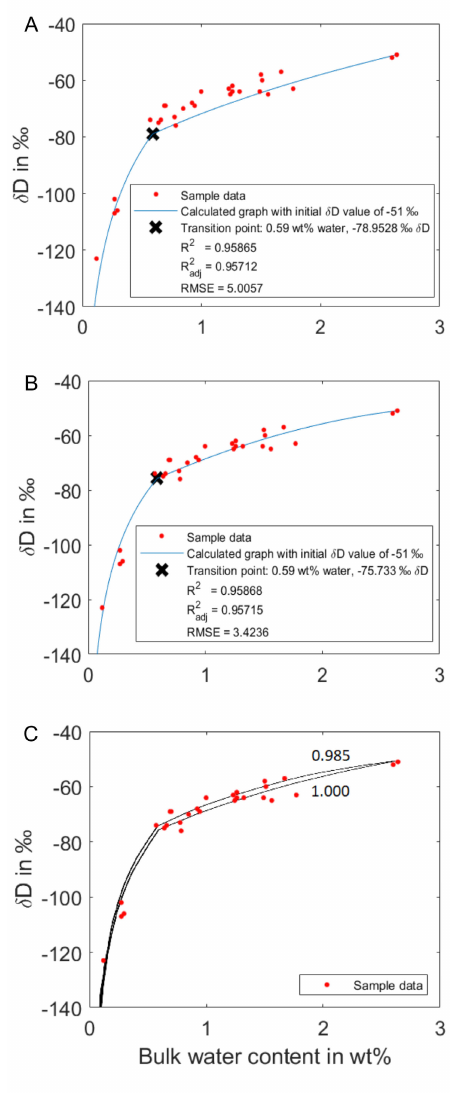
Figure 3: Diagrams illustrating δ D values versus bulk H O content (in wt.%) of the C.E. 1340 Mono Crater 2 eruption based on the sample data and initial values from [Dobson et al. 1989; Newman et al. 1988]. [A] and [B] show the computed values by VolcDeGas . The blue line displays the VolcDeGas simulated closed-, to open- system degassing graph, the red dots the sam- ple data and the black cross shows the transition where the degassing system changes. [C] presents a published Figure 2: Comparison of estimates of alpha factor plot- model fits to data from the literature [Dobson et al. ted against bulk H O content (in wt.%) for the C.E. 2 1989], with red dots being the sample data [Newman et al. 1988]. Numbers on two plots in [C] indicate the al- pha factor values used by Dobson et al. [1989]. The two VolcDeGas plots ([A], [B]) illustrate di ff erent fits arising from the contrasting α v ´ molecularwater values utilised. The alpha factor in [A] is based on speciation values which were calculated by the program (see Figure 2A), and in [B] on measured speciation values from Barnes et al. [2014] (see also Figure